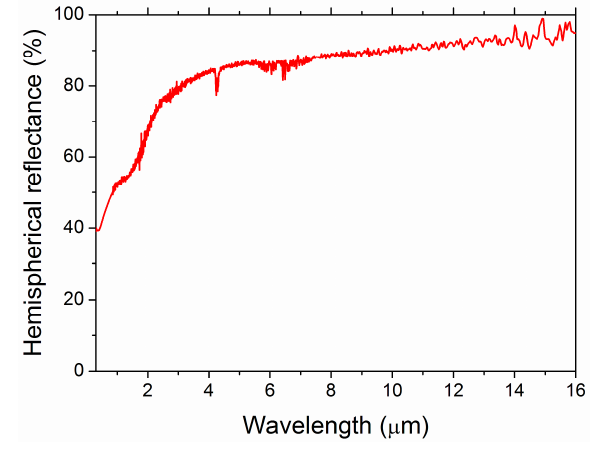
Figure 7. Hemispherical reflectance spectrum of ZrC sample.